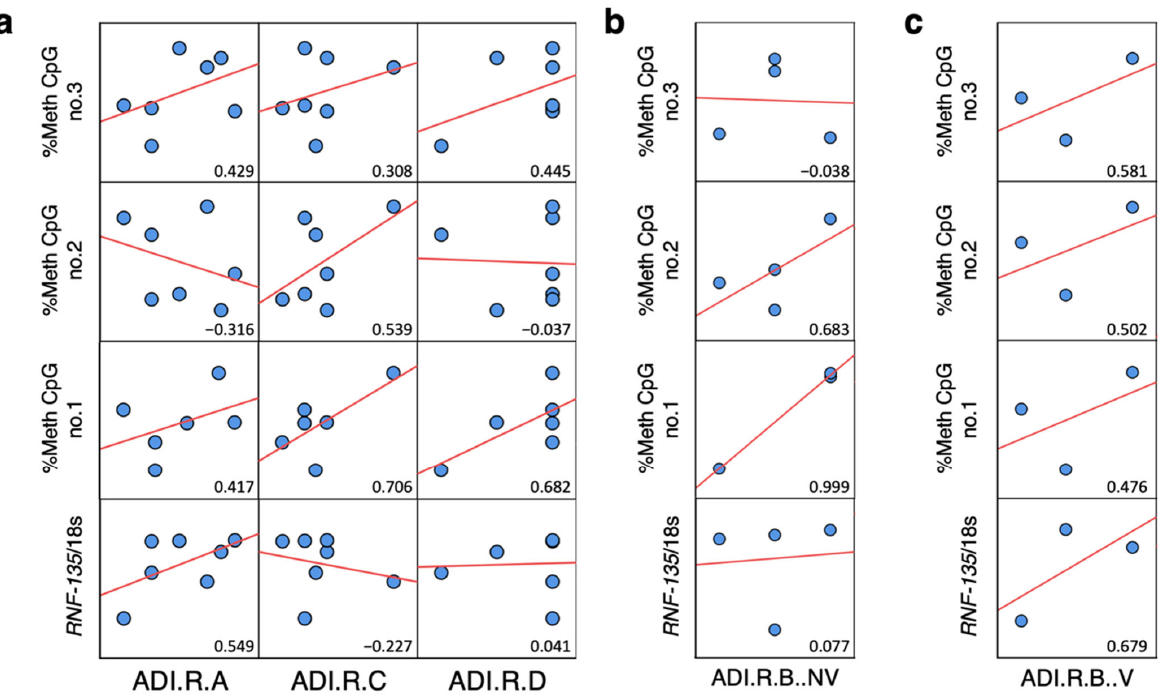
Figure 11. Correlation matrix between ADI-R scores, AluYk3 methylation, and RNF-135 expression in the prefrontal cortex: ( a ) Correlation between AluYk3 elements, the RNF-135 gene, and ADI-R A; social interaction, ADI-R C; restricted, repetitive, and stereotyped patterns of behavior, and ADI-R D; abnormality of development evident at or before 36 months. ( b ) Correlation between AluYk3 elements, the RNF-135 gene, and ADI-R B; nonverbal communication. ( c ) Correlation between AluYk3 elements, the RNF-135 gene, and ADI-R B; verbal communication. Red lines represent trend lines (linear model) and blue points represent ASD individuals.